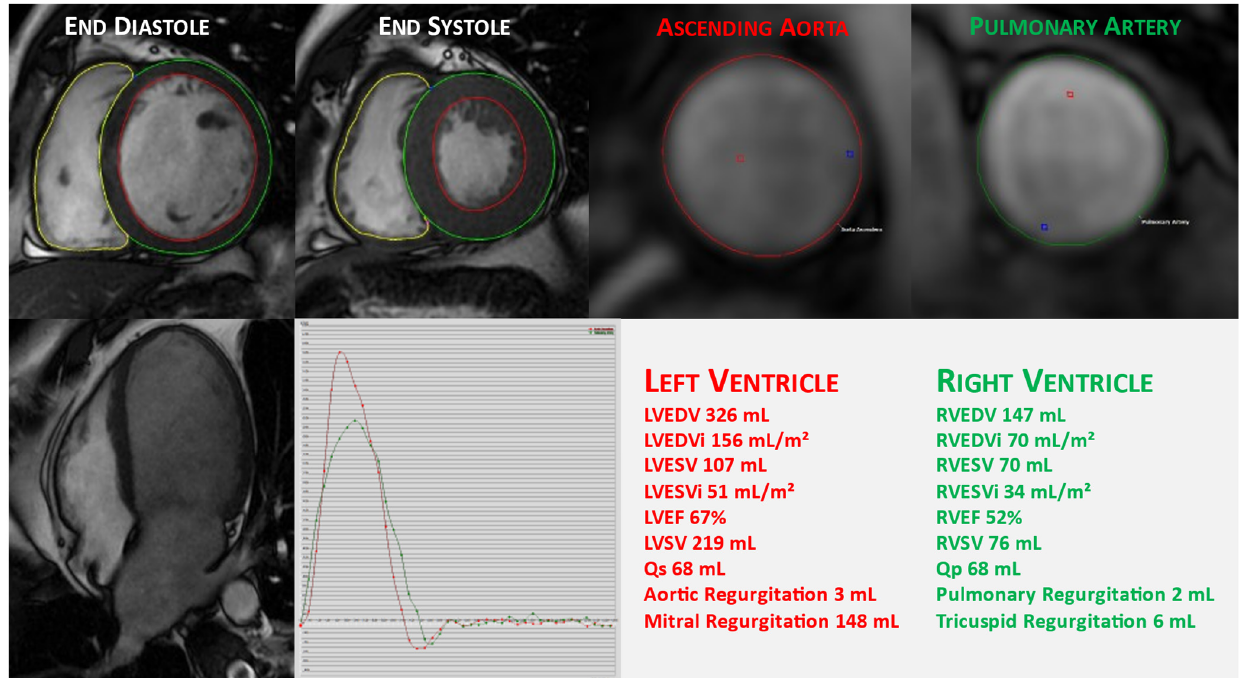
Figure 1. Cardiac magnetic resonance evaluation of mitral valve prolapse with severe mitral regurgitation. The quantification of valvular regurgitation by CMR: evaluation of left (LV) and right ventricular (RV) volumes, ejection fraction, and stroke volume using cine CMR acquisitions. The LV and RV endocardial contours are traced in the diastole and systole from a short-axis stack from the base to apex; aortic and pulmonary flows are assessed using the phase-contrast sequence, and an analysis of the fl ow time plot is displayed.